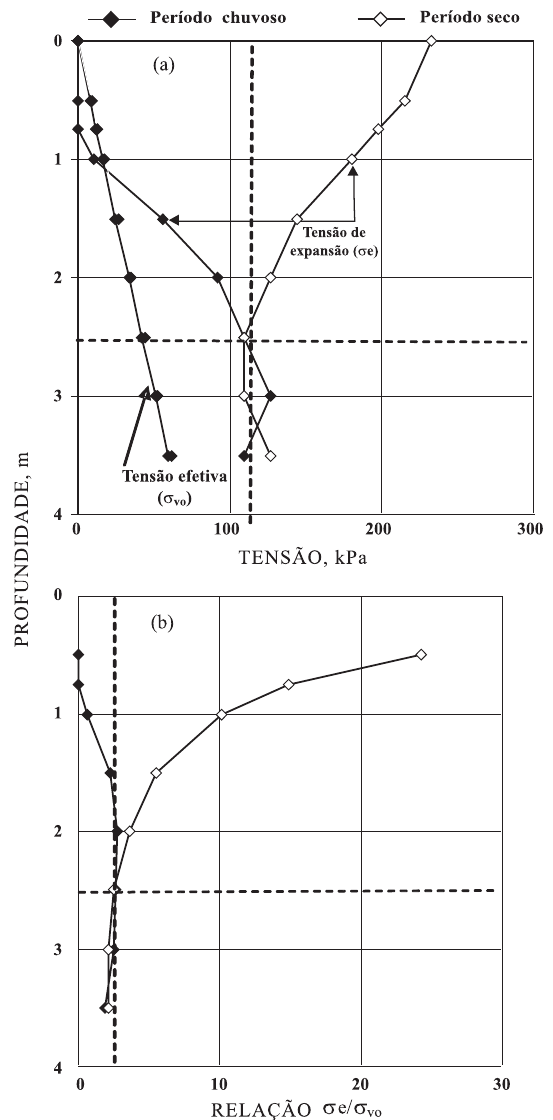
Figura 4. Variação, em diferentes profundidades, das tensões efetivas e de expansão obtida pelo método de volume constante em amostras coletadas nos períodos chuvoso e seco: (a) variação da tensão de expansão e efetiva em diferentes profundidades; (b) relação entre a tensão de expansão e a tensão